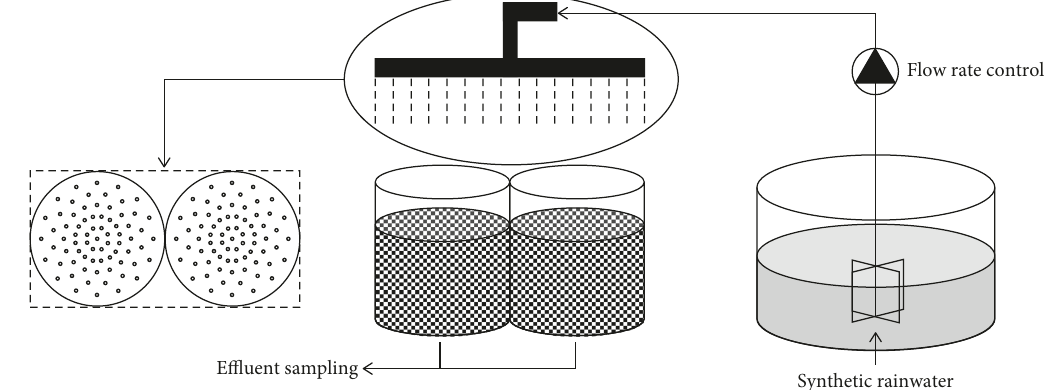
Figure 5: The scheme of the artificial rainfall